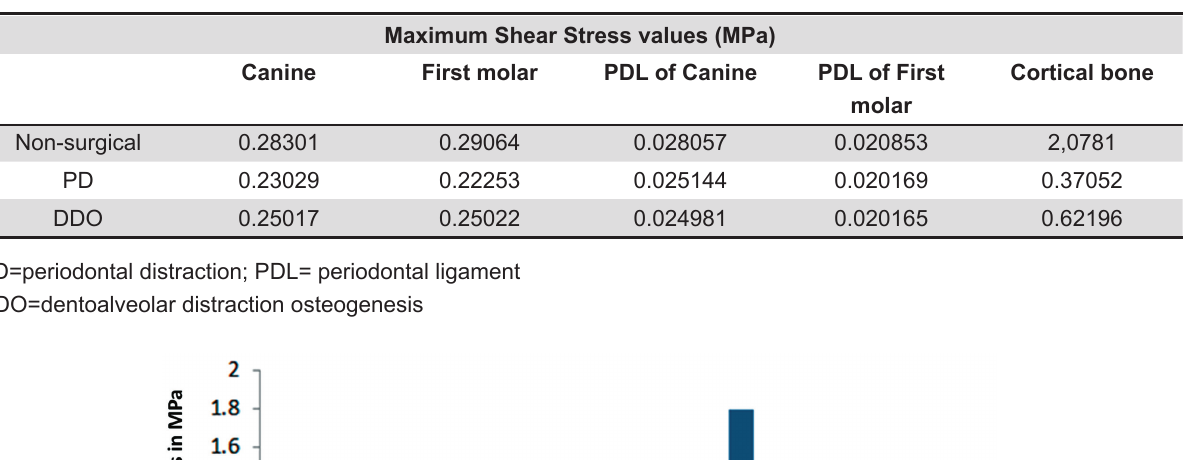
Table 3- Maximum Shear Stress values induced in three models